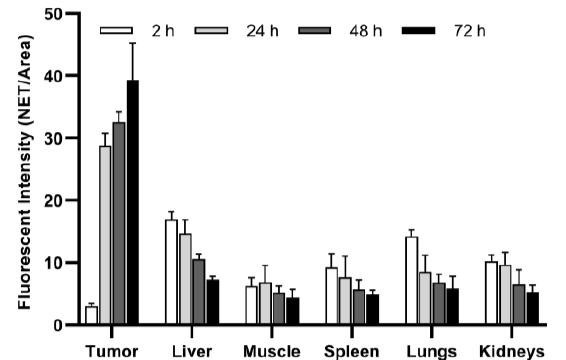
Figure 5. Biodistribution of PLGA-NPs in BALB/c mice. Data are expressed as average fluorescence (NET/Area) ± SD of five different mice per time point. Table 2. Ex vivo fluorescence (NET/Area) of organs at different time points.